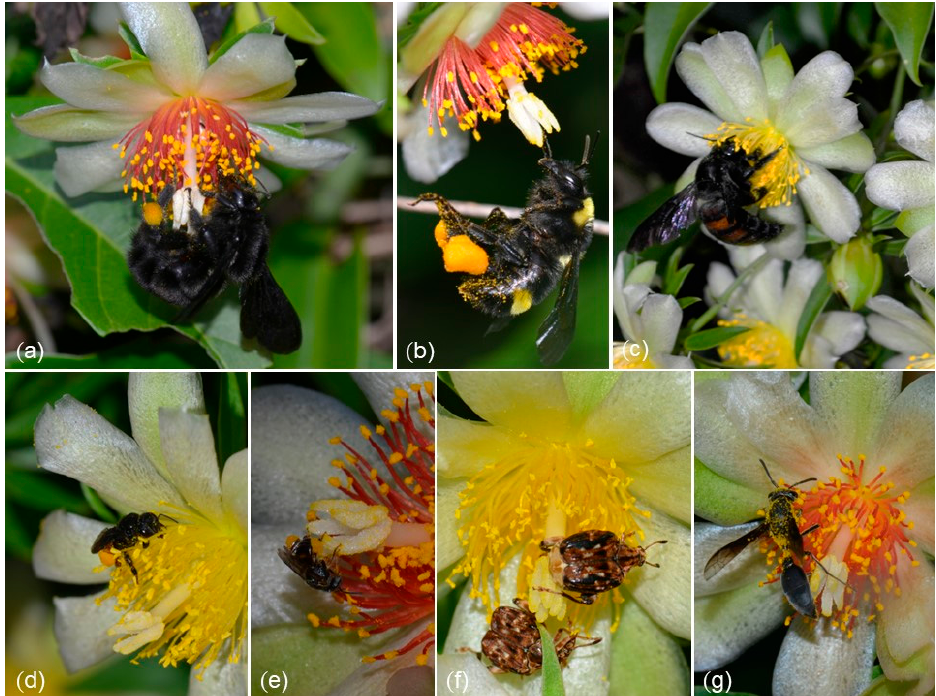
Figure 4. Diversity of pollinators in Pereskia aculeata . ( a ) Bombus morio . ( b ) Bombus pauloensis . ( c ) Xylocopa frontalis . ( d ) Scaptotrigona bipunctata . ( e ) Plebeia droryana . ( f ) Caryedes sp. ( g ) Polybia sp.